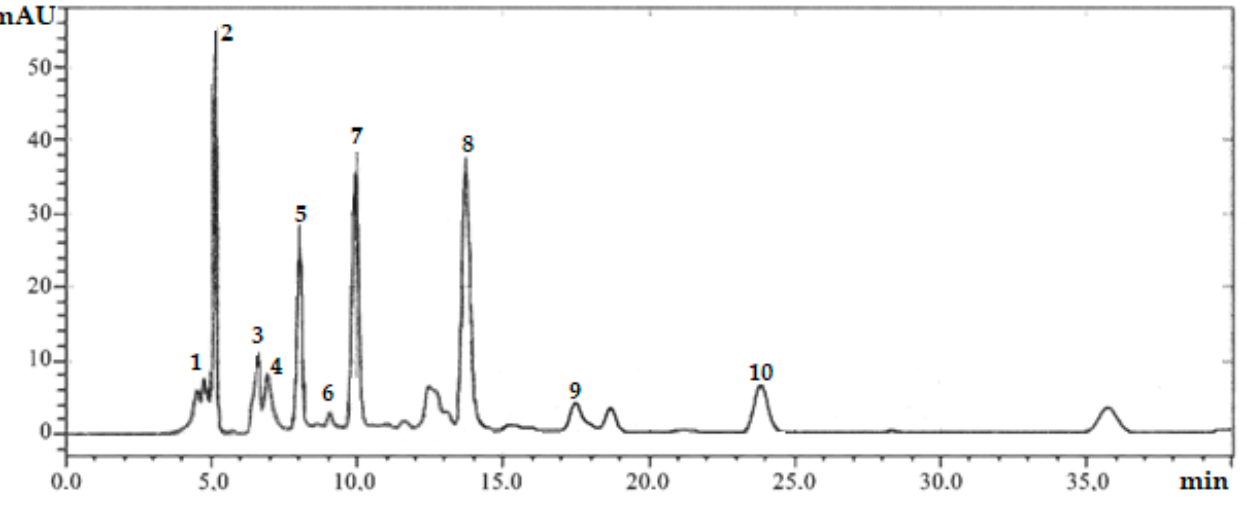
Figure 2. HPLC chromatogram of the extraction of Ginkgo biloba . Peak 1—ginkgolide A; peak 2— ginkgolide B; peak 3—bilobalide A; peak 4—ginkgolide C; peak 5—quercetin; peak 6—ginkgetin; peak 7—isorhamnetin; peak 8—luteolin; peak 9—kaempferol; peak 10—amentoflavone. The un- numbered peaks on the chromatogram belong to unidentified substances. Chromatographic con- ditions are as follows: mobile phase eluent A (water–acetonitrile 95:5 + 0.1% formic acid), mobile phase eluent B (acetonitrile–water 95:5 + 0.1% formic acid); flow rate 0.8 mL/min; column temper- ature 40 °C; injection volumes—20 µL; elution mode—gradient. Table 2. The component composition of Ginkgo biloba extract according to HPLC data. Peak No.